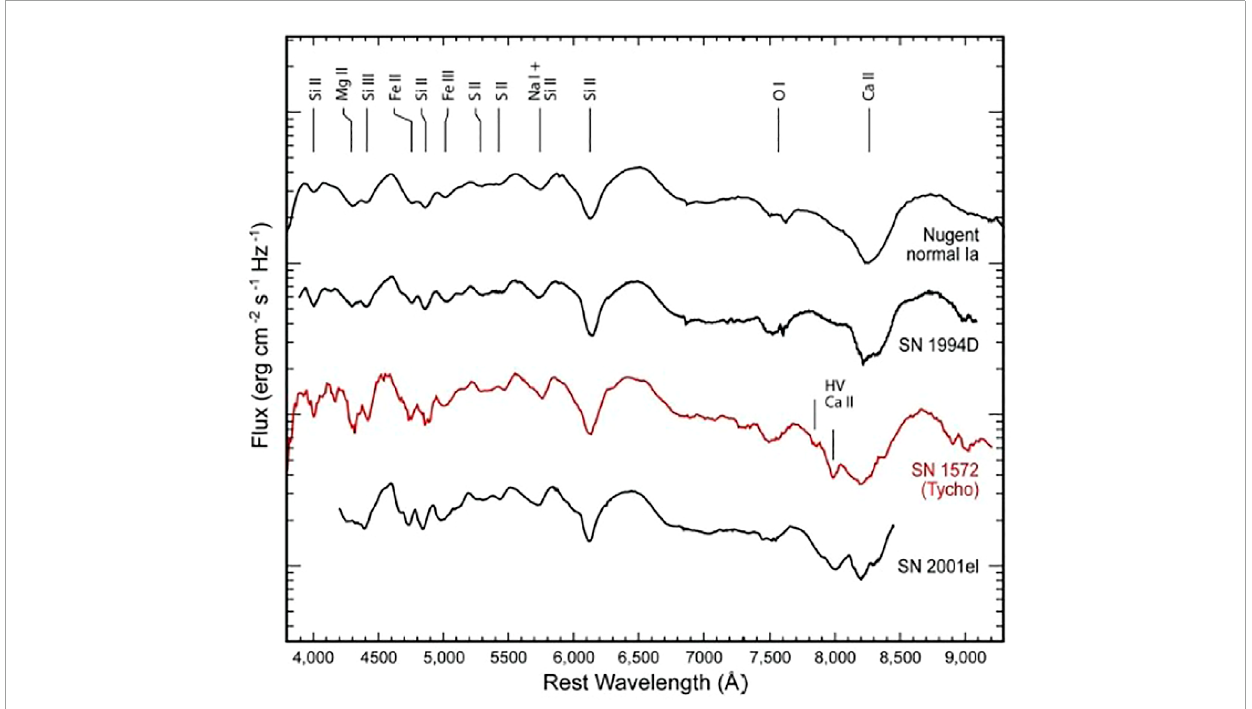
FIGURE 4 Spectrum of the light echo of SN 1572 compared with other normal SNe Ia. The spectra are weighted averages around maximum light. Figure from Krause et al. (2008). Courtesy of T. Usuda. © Springer Nature. Reproduced with